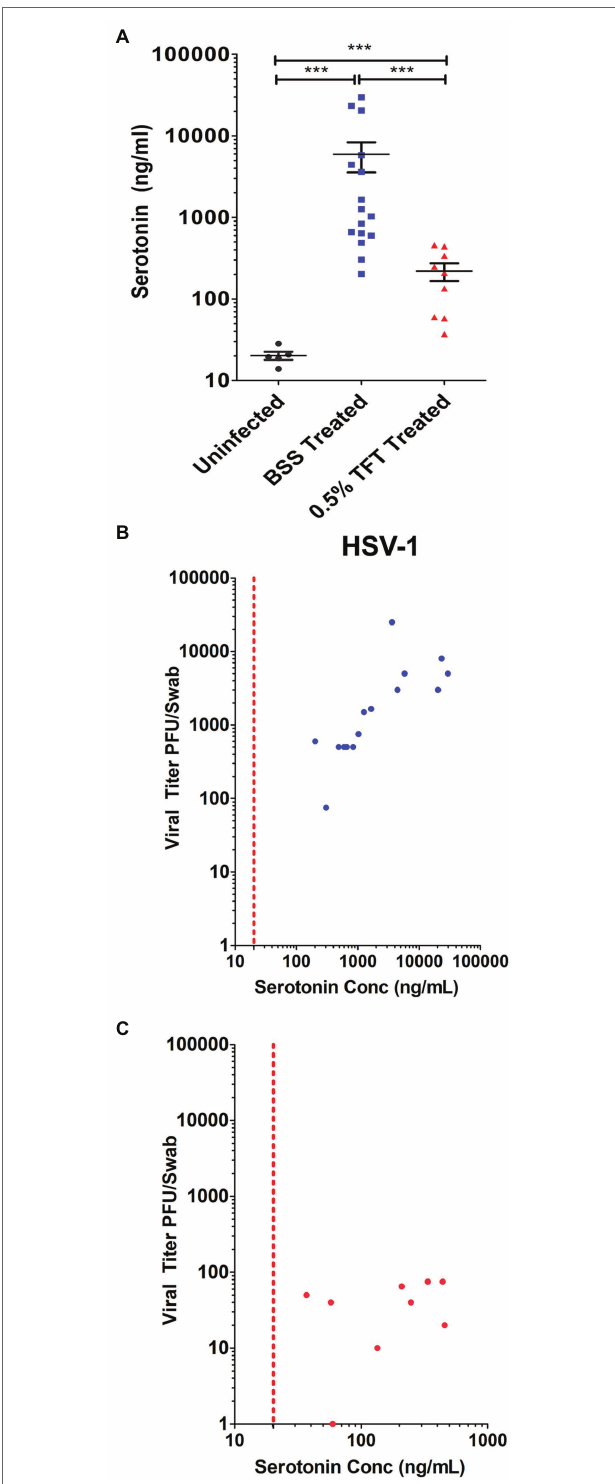
FIGURE 8 | Ocular serotonin concentrations correlate with levels of infectious HSV-1 shed in rabbit eye tear films. (A) Serotonin concentration was measured by ELISA from the aqueous humor of rabbits that were mock- or HSV-1-infected and subsequently had their eyes treated topically with either the ocular antiherpetic 0.5% TFT or a BSS Control. (B,C) Correlation